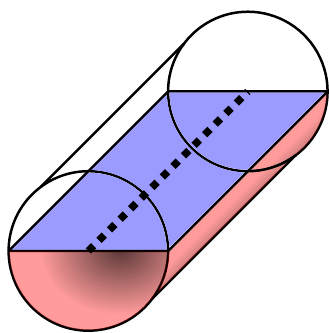
Figure 2. To obtain a perturbed thermofield double state, sources are inserted into the Euclidean path integral over the surface shown in red for global AdS 3 . The initial data are then read off from the blue surface. The dotted line indicates the horizon dividing the two black hole exteriors. If the two disks at the ends of the global AdS 3 cylinder are identified, then the black hole is spherical. A planar black hole is obtained by making the global AdS 3 cylinder infinitely